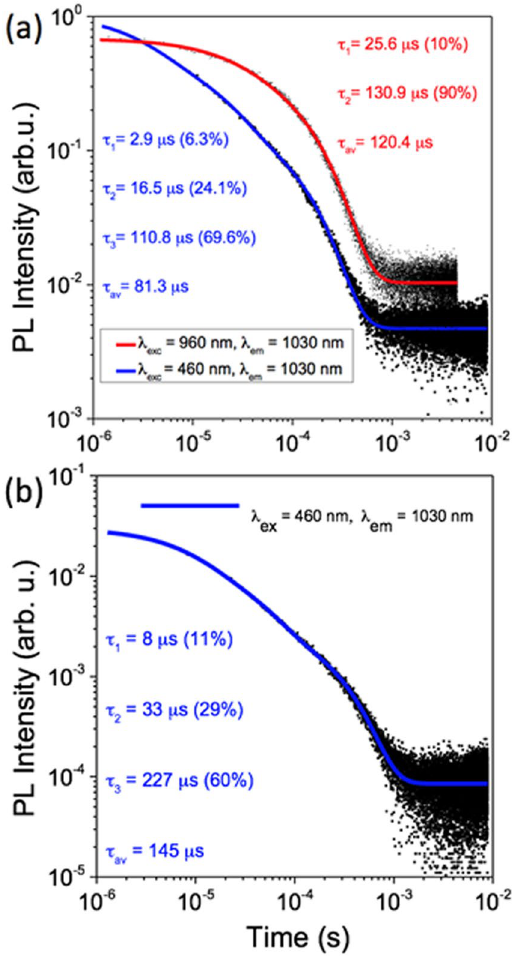
Figure 5. ( a ) Decay curves of 2-hydroxyperfluoroanthraquinone-capped 10% Yb 3 + -doped NaYF 4 nanoparticles (chromophore/nanoparticle suspension concentration ratio of 0.44) with 460 nm and 960 nm OPO excitations. ( b ) I(t) decay curve and fittings for the 1030 nm emission at the 460 nm OPO excitation for the 0.37 mg/ml chromophore functionalized nanoparticle at the high chromophore/NaYF 4 : Yb 3 + nanoparticles suspension concentration ratio of 1.04. The numbers in the brackets are the percentage contribution to the average